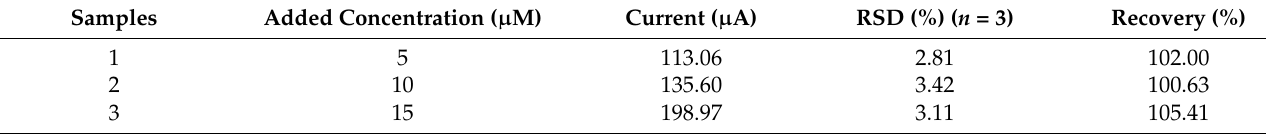
Table 4. Determination of 4-AP in paracetamol tablet samples.